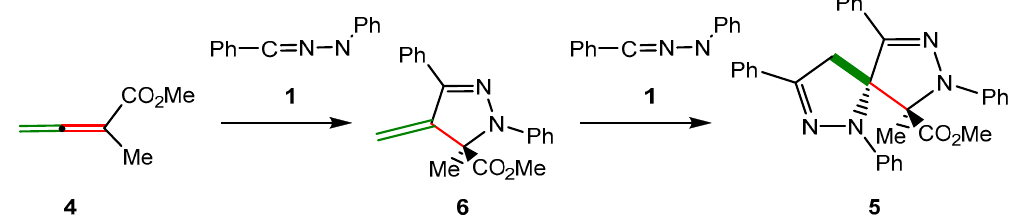
Scheme 3. Proposed mechanism for the domino reaction between diphenyl NI 1 with allenoate 4 yielding spirobipyrazoline 5